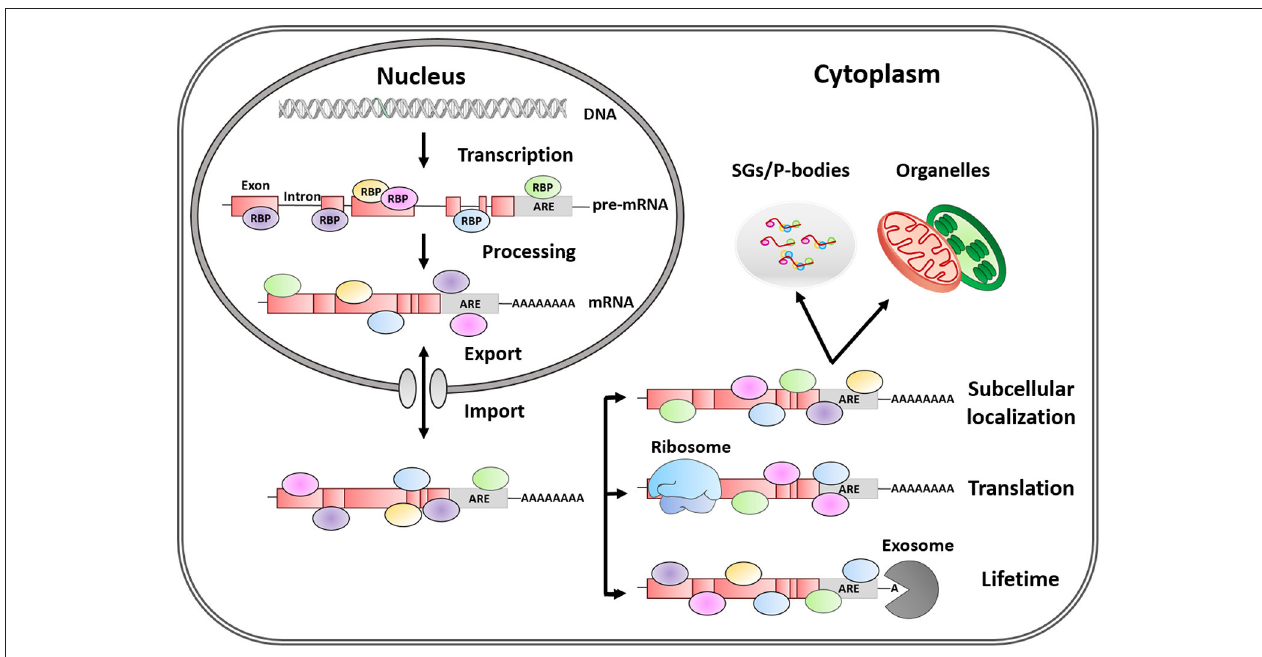
FIGURE 1 | Post-transcriptional regulation of mRNA fate by RNA-binding proteins. RBPs are trans-acting elements, that shuttle between the nucleus and the cytoplasm, and influence mRNA fate by binding to regulatory sequences (cis-acting elements). AREs are the most common regulatory elements in 3 ′ UTR, and the binding of RBPs to these regions plays a key role in the life of mRNAs by regulating alternative mRNA splicing, maturation, transport, subcellular location, lifetime, and